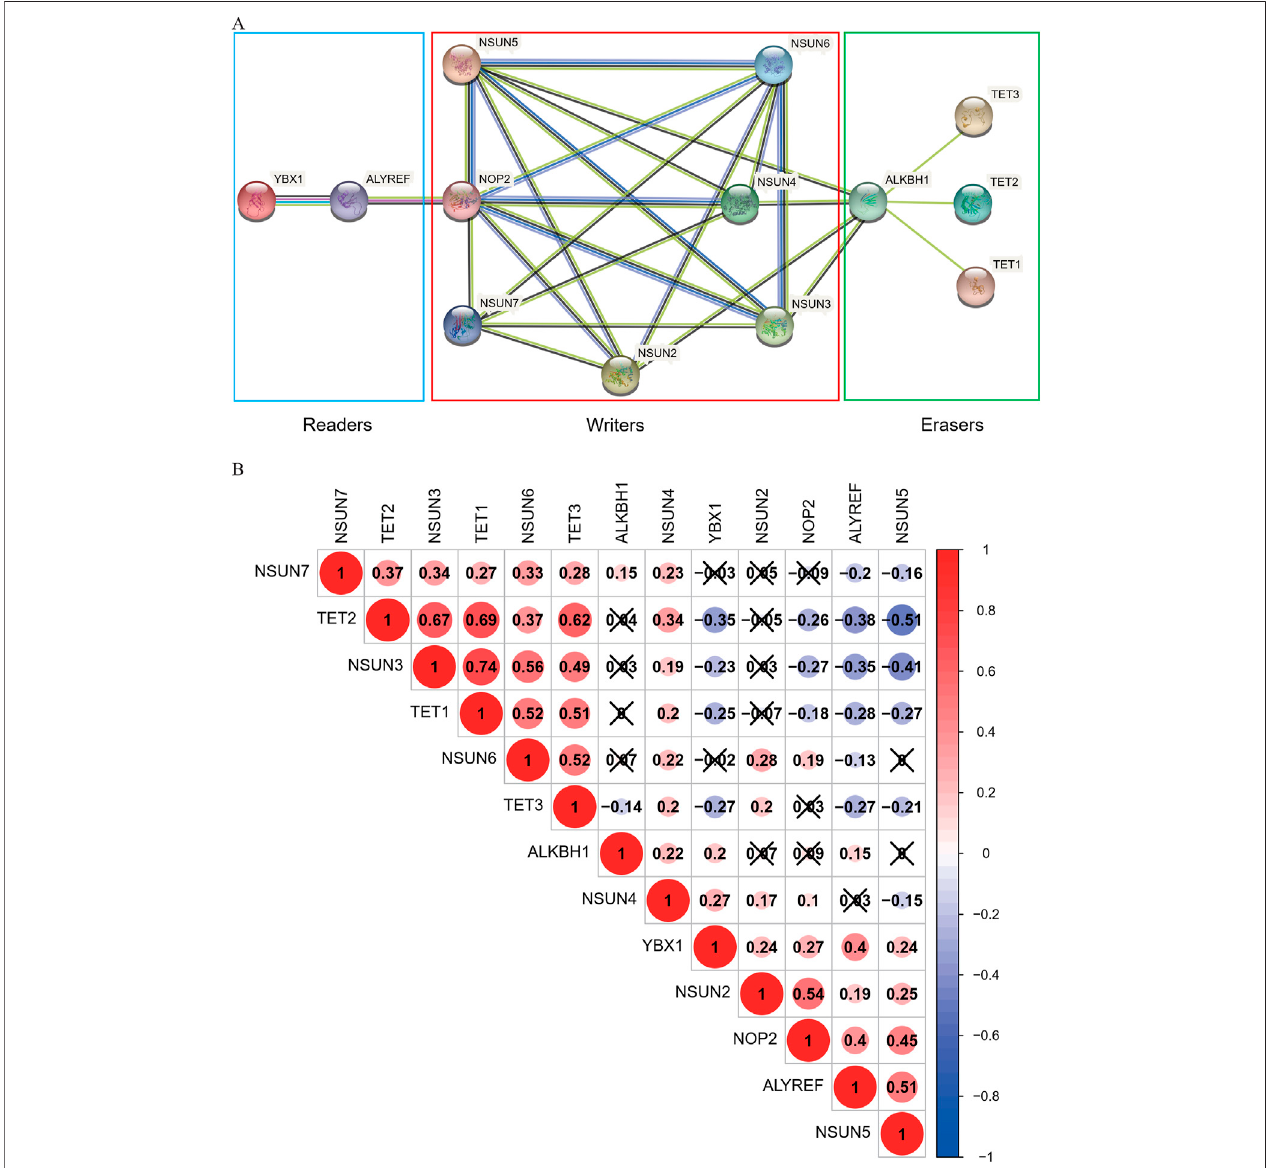
FIGURE 3 | Correlation and interaction of m 5 C-related regulators in COAD. (A) The PPI network of the 13 m 5 C-related regulators was constructed using STRING. (B) Spearman correlation analysis of the 13 m 5 C-related regulators.